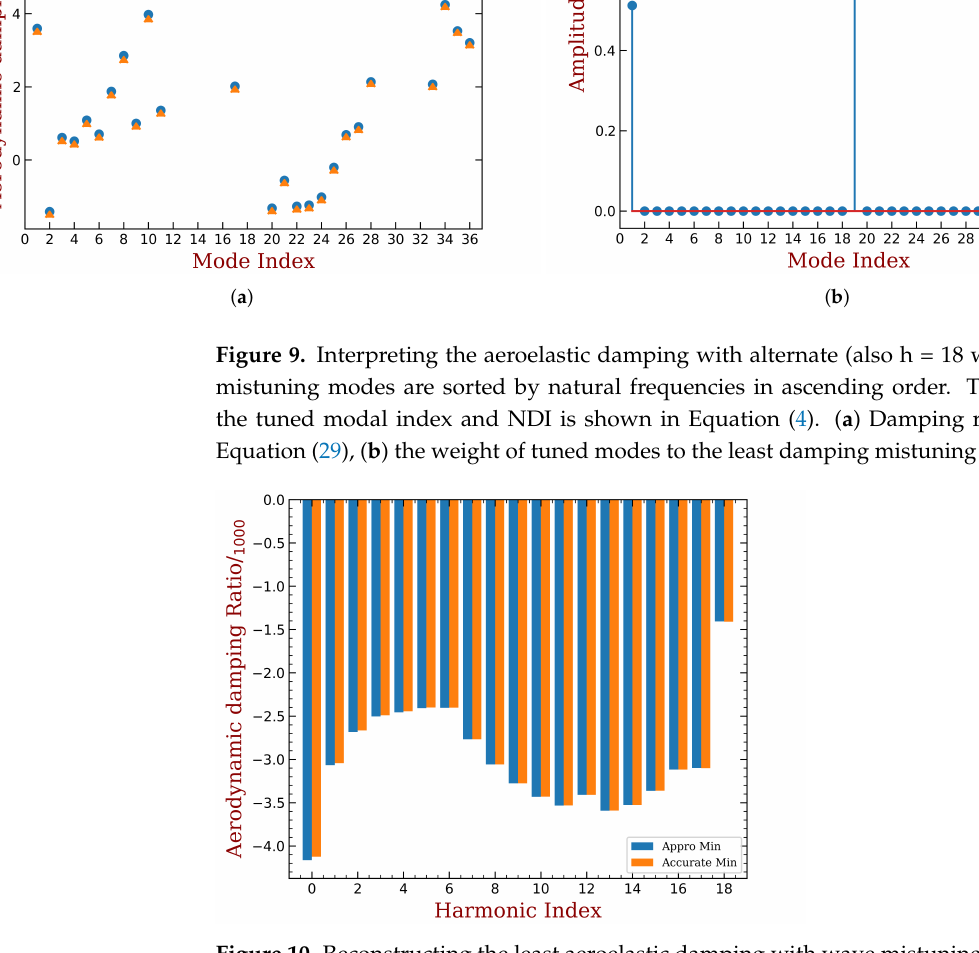
Figure 10. Reconstructing the least aeroelastic damping with wave mistuning, from h = 0 to h =